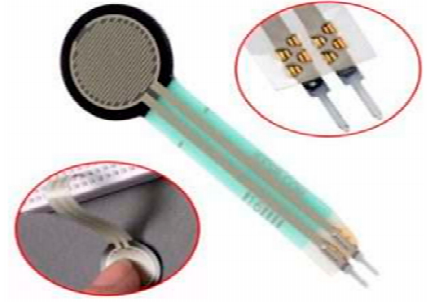
Figure 6. Tactile sensor or force resistive sensor [101].